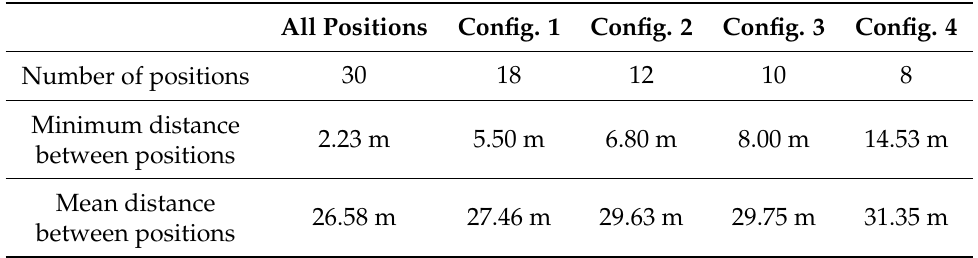
Table 3. Training resolution configurations.